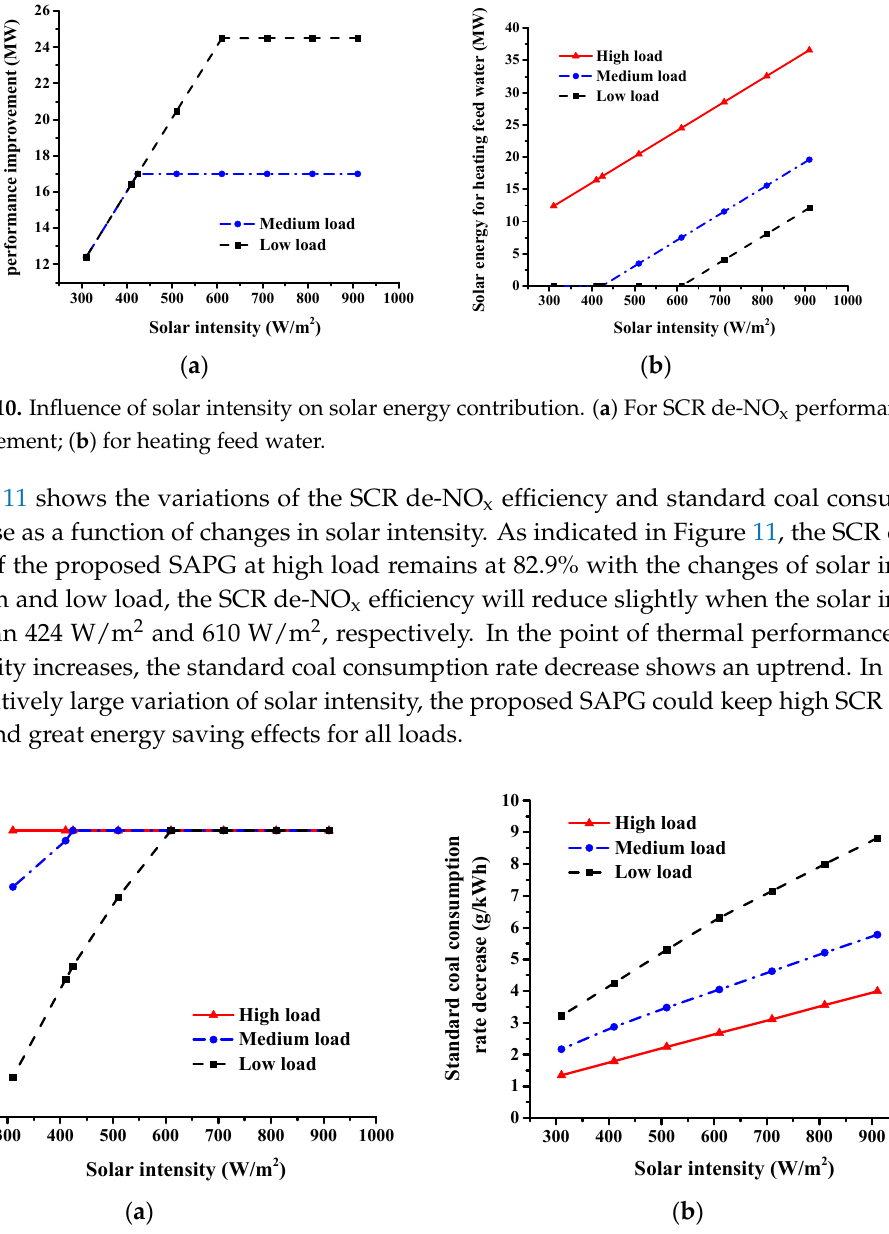
Table 10. Economic performances of the proposed SAPG. Items Proposed SAPG